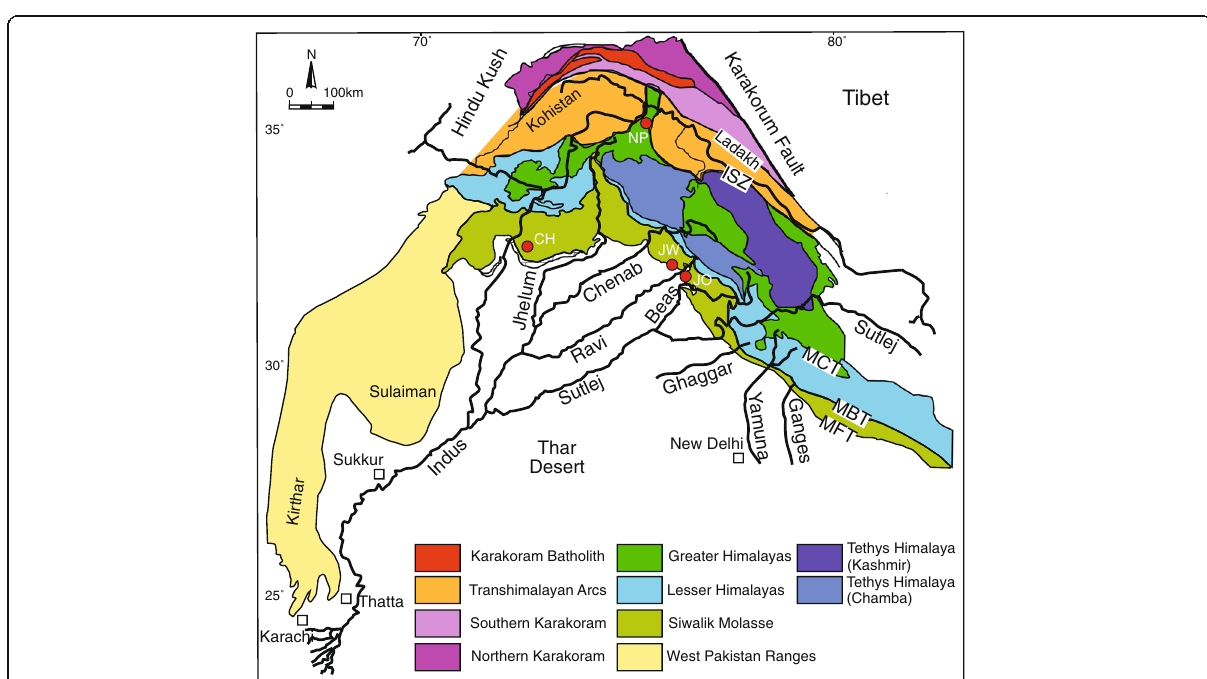
Fig. 3 Geological map of the study area showing the major tectonic units that are eroded by the Indus River and its tributaries. Map is modified after Garzanti et al. (2005). Rivers as shown in thick black lines. ISZ = Indus Suture Zone, MCT = Main Central Thrust, MBT = Main Boundary Thrust and MFT = Main Frontal Thrust. Sample locations are shown as filled circles. Thick black line shows major Himalayan tributaries. CH —